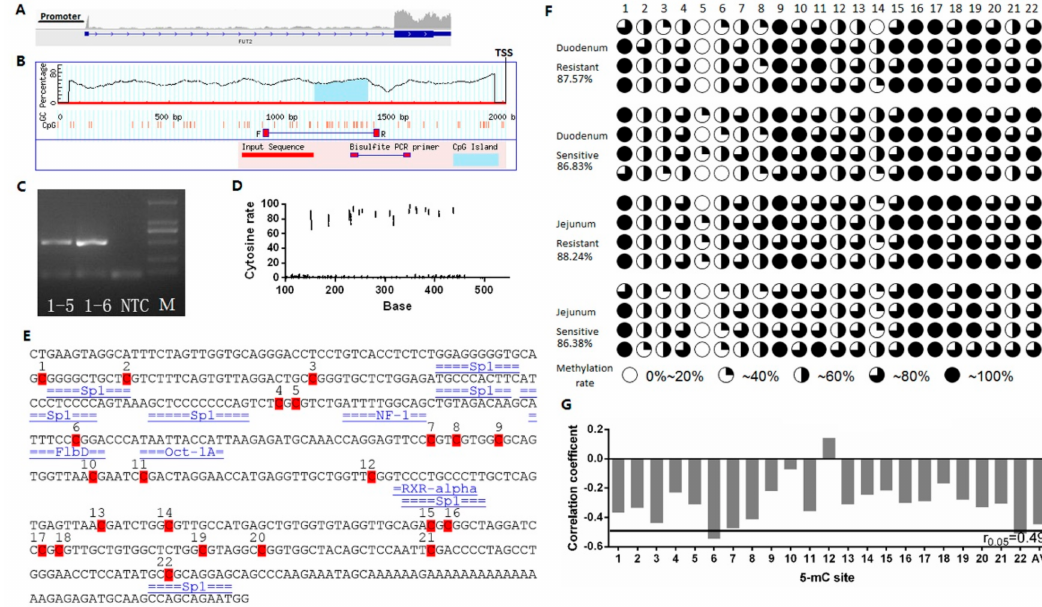
Figure 7. The effect of the FUT2 promoter methylation level on gene expression ( A ) FUT2 gene promoter analysis of transcriptome sequencing results through Integrative Genomics Viewer digging. Different peaks represent the differences in the expression quantity of different exon regions; the long blue bar represents the pig genome sequence information in the database; gray bars indicate the transcriptome sequencing reads after stitching; TSS: transcriptional start site; ( B ) Detection of the FUT2 gene promoter CpG islands; ( C ) Agarose gel electrophoresis of FUT2 methylation primer amplification products, Lanes 1–5, 1–6: template PCR product; NTC: no template control PCR product; M: DL2000 DNA Marker; ( D ) Cytosine ratio of the amplified fragments; ( E ) Sequence analysis of FUT2 gene methylation detection; ( F ) Methylation level of the FUT2 gene amplified fragment in the duodenum and jejunum; Red box represents CpG sites; ( G ) Correlation analysis between the FUT2 gene amplified fragment methylation and mRNA expression level, AV: the average degree of